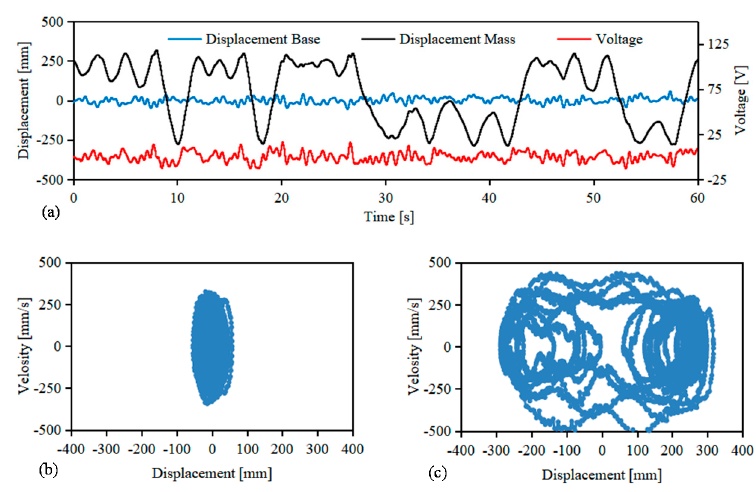
Figure 20. Measurement results of response vibration displacement and vibration power generation when vibrating with a random signal and a period signal 0.45 Hz of large amplitude 25 mm. ( a ) Results of response vibration displacement. ( b ) Diagram of displacement velocity of vibration of the support. ( c ) Diagram of displacement velocity of vibration of the mass block.